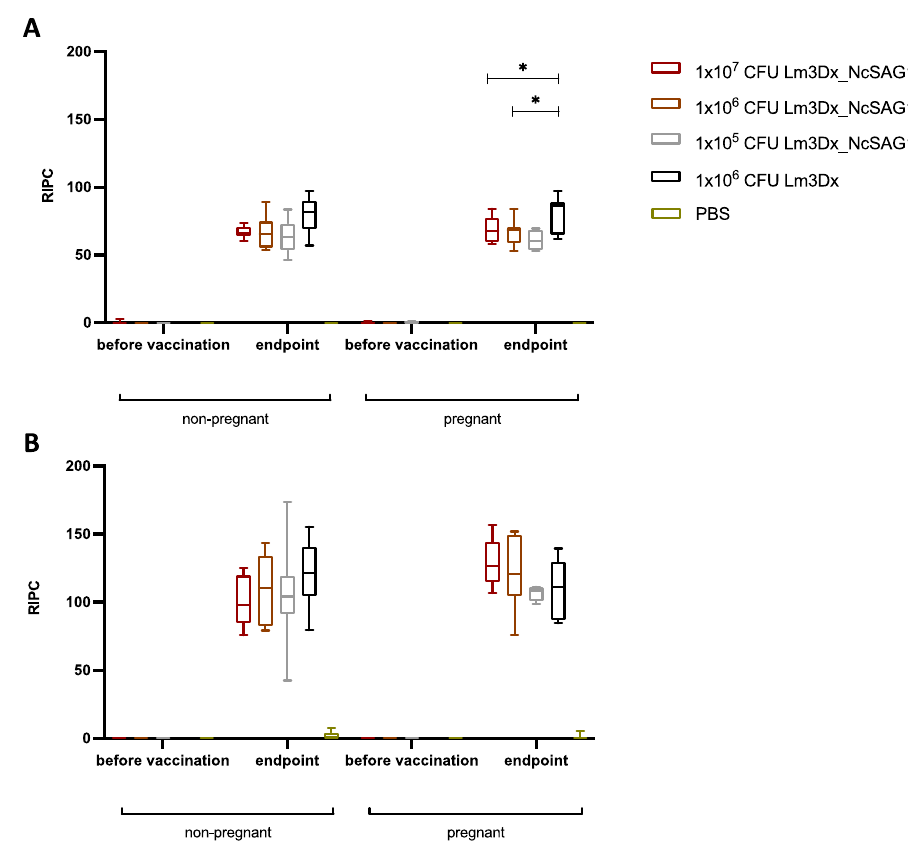
Figure 4. Humoral immune responses (IgG) directed against N. caninum extract ( A ) and recombinant NcSAG1 ( B ). Sera were collected prior to vaccination and at the endpoint (38–40 days post challenge) from non-pregnant and pregnant mice. Results are expressed as the mean of RIPC (relative index per cent) compared to the respective positive control that received the empty vector only. ( A ) No significant differences in IgG levels against N. caninum were detected between vaccinated non-pregnant mice and the respective positive control, whereas in dams, IgG antibody titers were significantly decreased at the two higher vaccination doses compared to the positive control group (* p < 0.0434 for 1 × 10 7 CFU; * p < 0.0343 for 1 × 10 6 CFU; Mann–Whitney ‐ U test) but not between the lowest vaccination dose (1 × 10 5 CFU) and the positive control. ( B ) Antibody titers directed against recombinant NcSAG1 did not differ significantly in any of the groups.